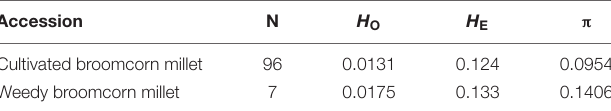
TABLE 1 | Genetic diversity parameters of weedy and cultivated broomcorn millets.